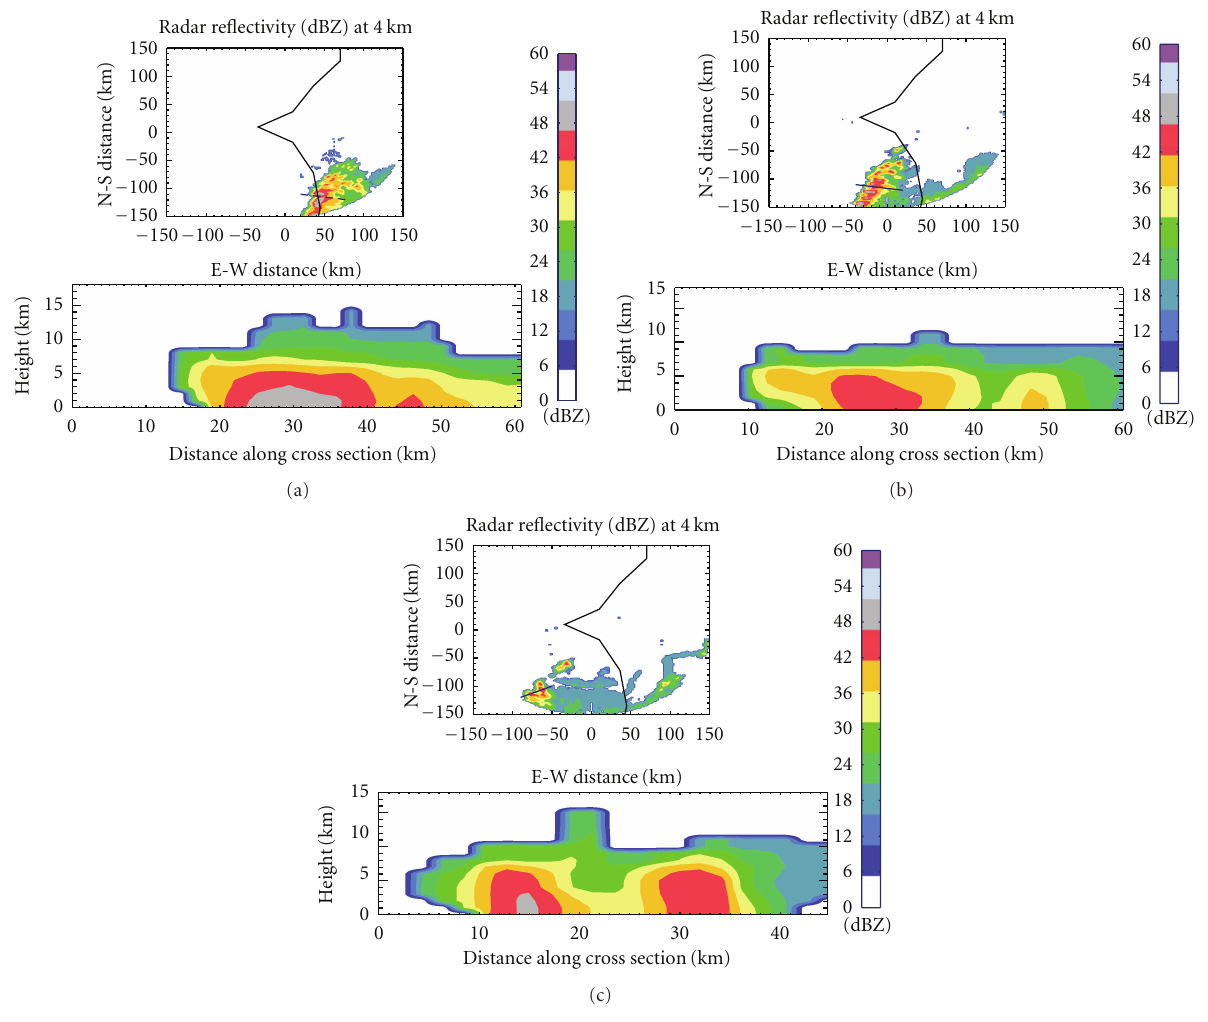
Figure 9: (a) A horizontal constant altitude plan position indicator (CAPPI) image at 4.0km altitude and radar height indicator RHI plots of the NPOL radar reflectivity (dBZ) along the leading convective line on 11 September 2006 at 0900 UTC. The negative sign in the CAPPI images indicates distance in the westward direction. The dashed line in the CAPPI image represents the location of the cross section. In the RHI images, ordinate axis is height z in km and the azimuthal is the distance in km along the cross-section. (b) A horizontal constant altitude plan position indicator (CAPPI) image at 4.0 km altitude and radar height indicator RHI plots of the NPOL radar reflectivity (dBZ) along the leading convective line on 11 September 2006 at 1000 UTC. The negative sign in the CAPPI images indicates distance in the westward direction. The dashed line in the CAPPI image represents the location of the cross section. In the RHI images, ordinate axis is height z in km and the azimuthal is the distance in km along the cross-section. (c) A horizontal constant altitude plan position indicator (CAPPI) image at 4.0km altitude and radar height indicator RHI plots of the NPOL radar reflectivity (dBZ) along the leading convective line on 11 September 2006 at 1100 UTC. The negative sign in the CAPPI images indicates distance in the westward direction. The dashed line in the CAPPI image represents the location of the cross section. In the RHI images, ordinate axis is height z in km and the azimuthal is the distance in km along the